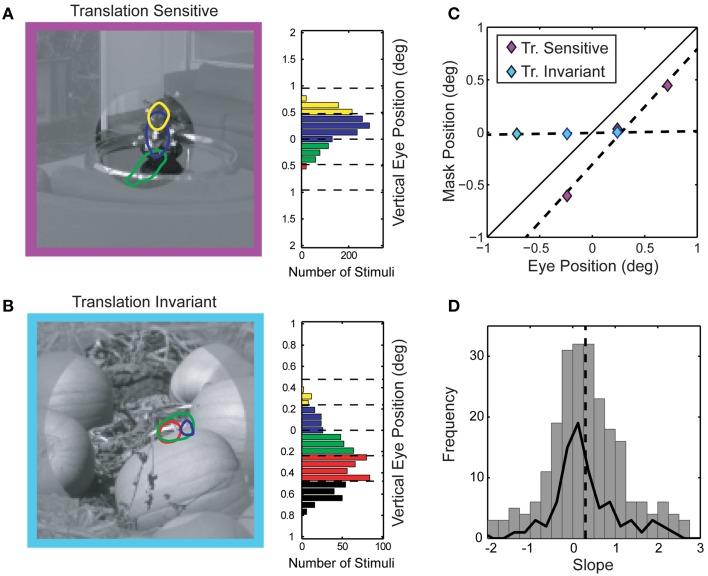
Position sensitivity of spike-triggered masks. (A) Gaze-angle contingent spike-triggered masks from a position sensitive V4 neuron. Colors (masks and histograms) denote modal vertical eye position and correspond to the eye position histogram on the right. The portion of image shown in low contrast was not visible during experiments and is shown here for display purposes only. The linear relationship between mask position and gaze angle is diagnostic for positive sensitivity (see text for explanation). (B) Position insensitive V4 neuron. For this neuron, the spike-triggered masks do not shift with eye position but rather remain fixed in head-centered coordinates. (C) Center of mass (vertical component only) of each of the spike-triggered masks from (A) and (B) plotted as a function of vertical eye position. (D) Distribution of position sensitivity slopes across the population of neurons. Average slope of 0.30 ± 1.61 is indicated by the dashed line (n = 206 spike-triggered masks). Solid line indicates the distribution of position sensitivity slopes for each neuron, averaging the slope across all spike-triggered masks for that neuron (n = 84 neurons). The average slope was significantly less than one, indicating a degree of position invariance across the population of V4 neurons studied.